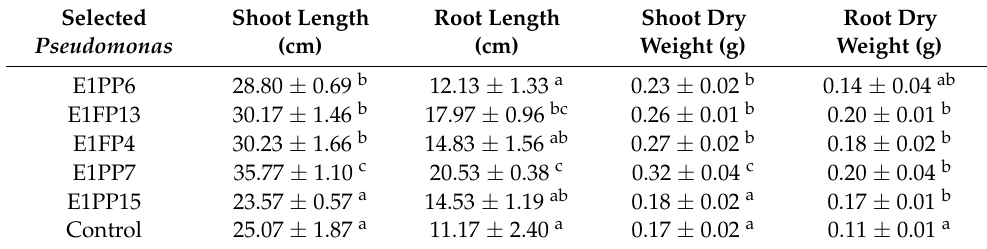
Table 3. Effect of selected Pseudomonas strains on the shoot and root growth of